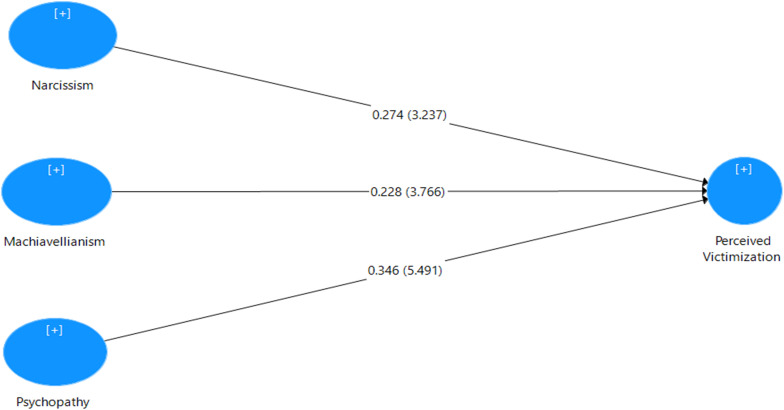
Structural model for direct relationship.